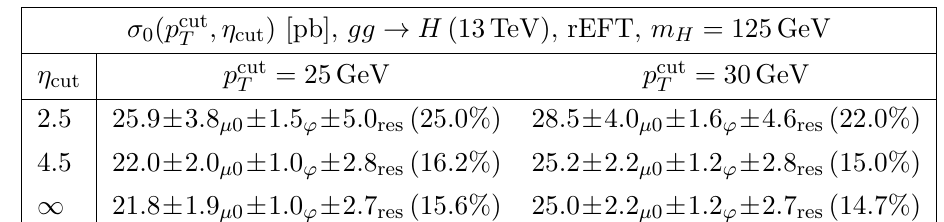
; (cid:17) cut ) for gg H for m H = 125 GeV at NLL 0 +NLO for T ! (cid:1) ’ (cid:1) res . The absolute (cid:8) (cid:8) . 1